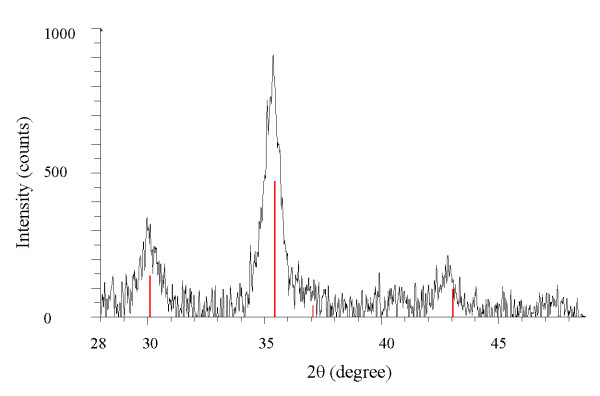
XRD pattern of Fe3O4 nanoparticles with 9.8 nm diameter.